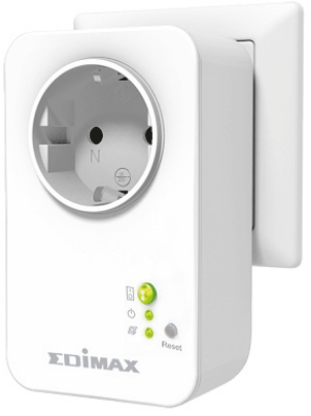
Figure 5: Edimax smart